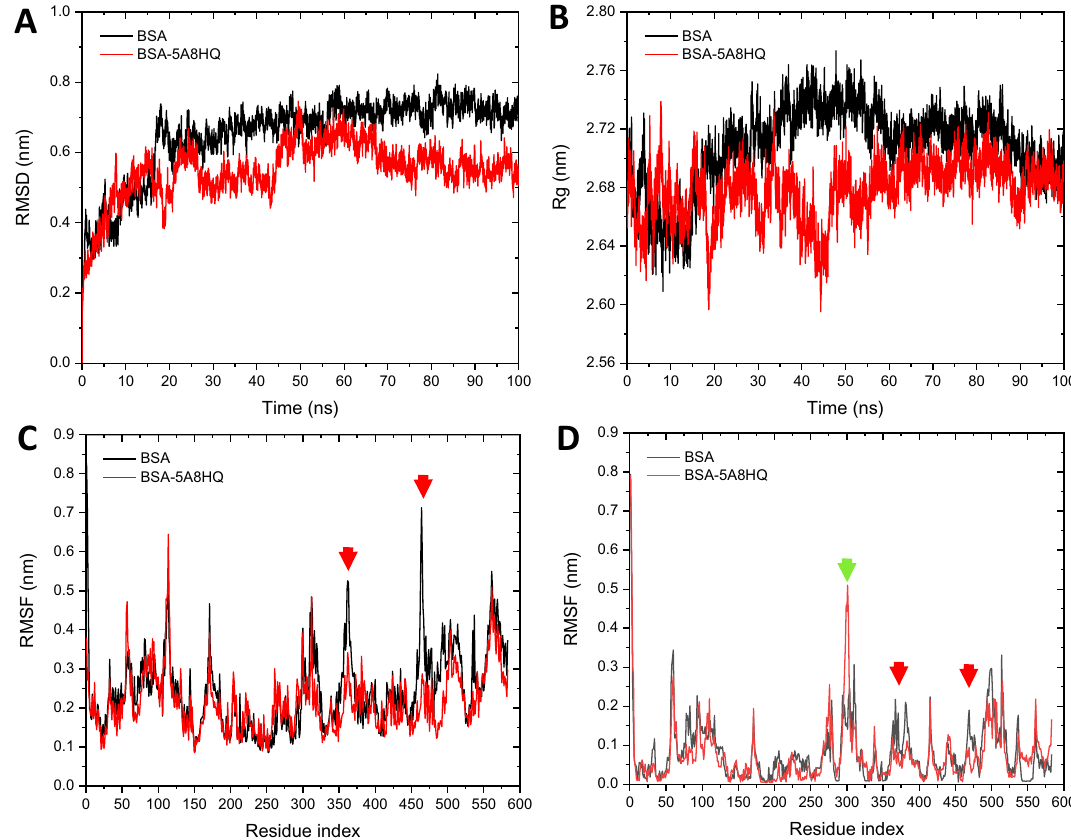
Figure 10. Molecular dynamics simulation results of free BSA and BSA ‒ 5A8HQ complex derived from GROMACS ( A – C ) and CABS-flex ( D ) platforms. ( A ) Root mean square deviation (RMSD), ( B ) radius of gyration trajectory (Rg), and ( C ) root mean square fluctuation (RMSF) trajectories from GROMACS. ( D ) Residue fluctuation profile from